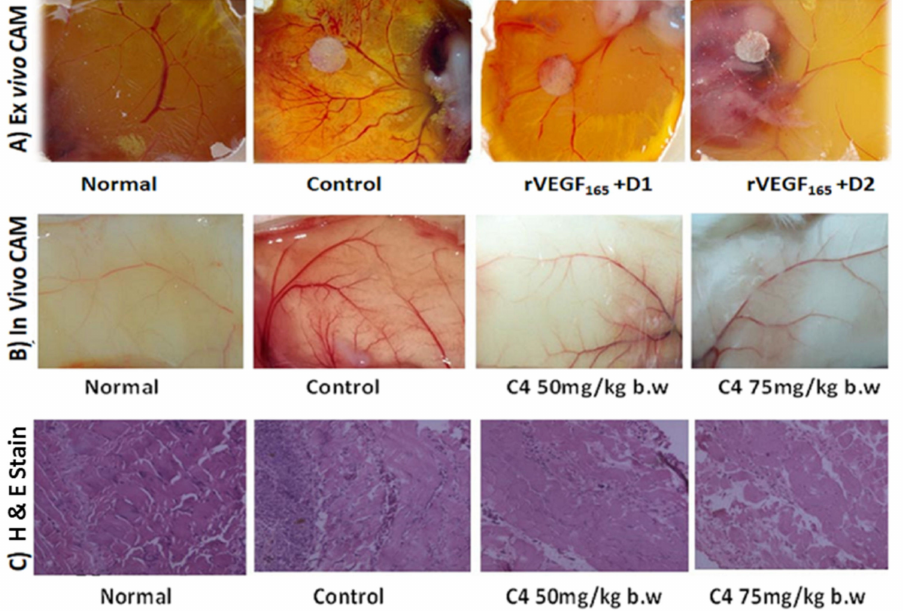
Figure 5. Represents the effect of complex C4 on Ehrlich Ascites Carcinoma (EAC) in mice. The EAC cells intraperitoneal injected induced an ascite tumor in one and half month-old Swiss albino mice. Two doses of complex C4 (50 mg/kg and 75 mg/kg) were each administered to the tumor-bearing mice on alternate days after three days of tumor growth. ( a ) Morphology of tumor bearing mice. ( b ) Repressed tumor volume. ( c ) Repressed tumor volume in gram. ( d ) Decrease in ascites secretion. ( e ) Reduction in tumor cell proliferations were analyzed by control versus treated. ( f ) Kaplan–Meier showing the extended survivability.